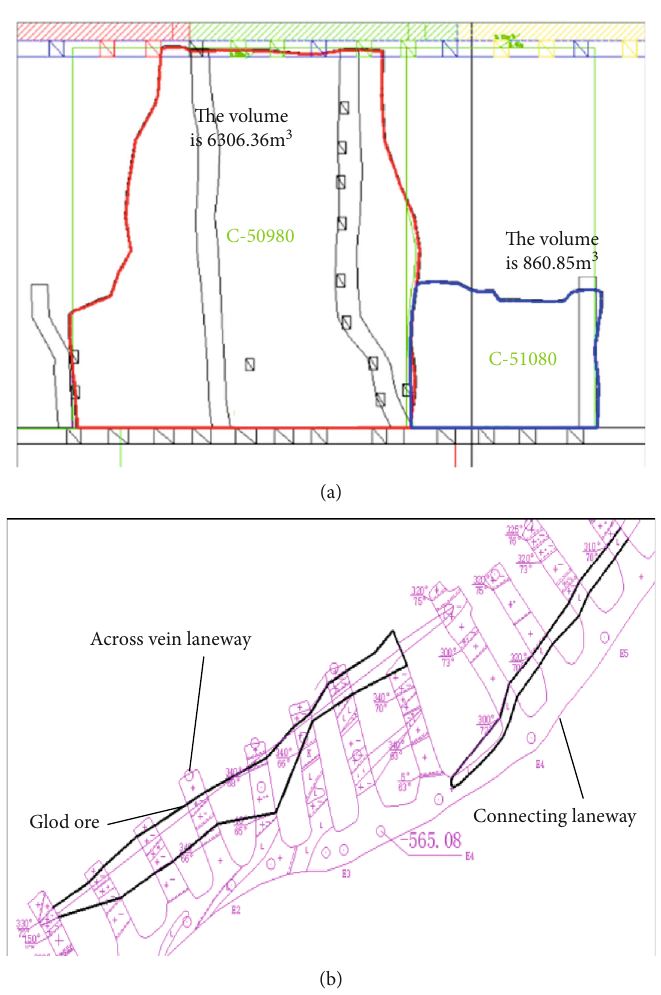
Figure 7: (a) The vertical projection map of goafs and (b) the fl oor plan of -565 m.